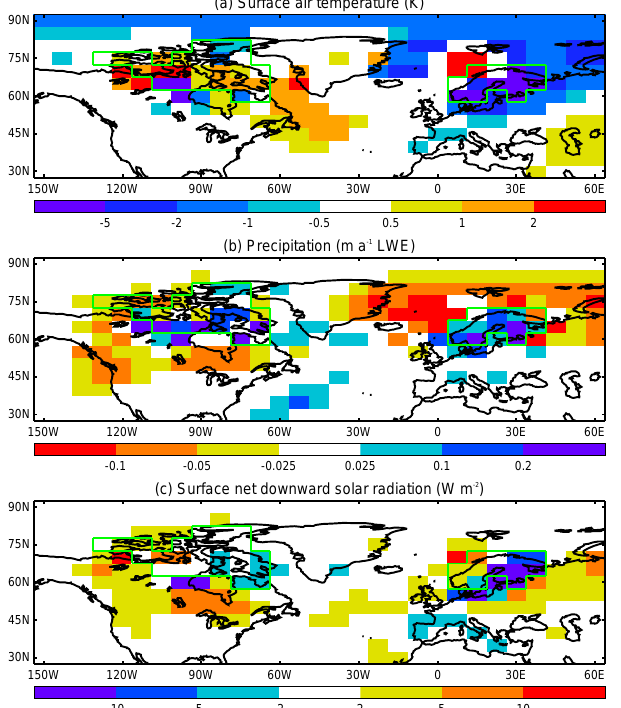
Fig. 10. Difference in the quantities indicated between the final steady state and the time-mean of years 1–100 of the synchronously coupled experiment for the incipient glacial climate (final minus ini- tial). The green line shows the extent of the ice-sheet during years 1–100, as defined in the text. Changes are shown only where they differ from internal variability, as determined by a two-tailed Stu- dent t -test at a significance level of 5%.